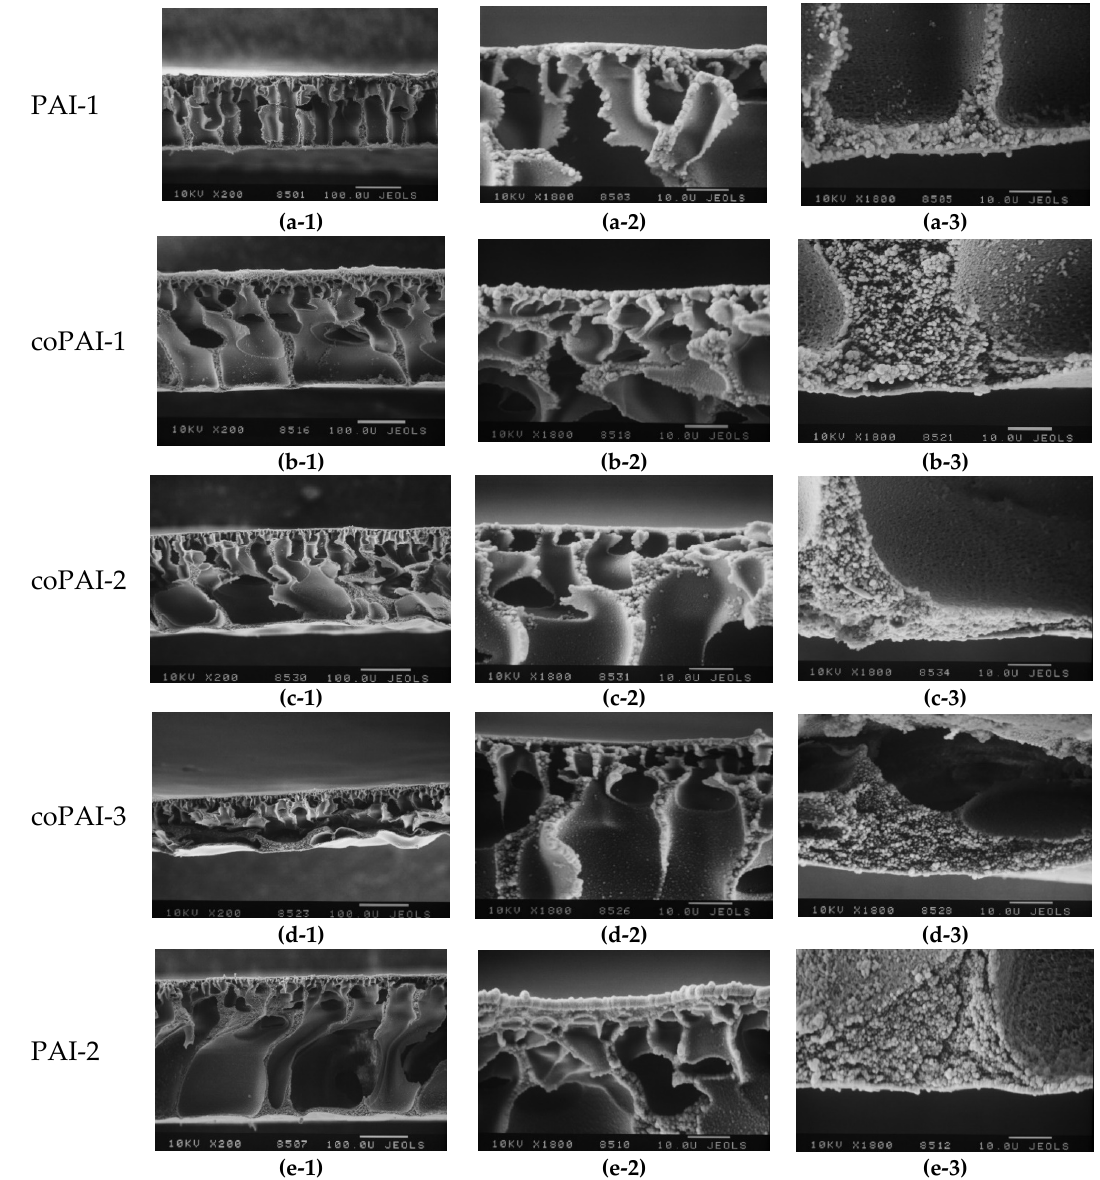
Figure 8. SEM images of low-temperature fractures of asymmetric membranes PAI-1(0% DABA; a-1 , a-2 , a-3 ), coPAI-1(30% DABA; b-1 , b-2 , b-3 ), coPAI-2 (50% DABA; c-1 , c-2 , c-3 ), coPAI-3 (70% DABA; d-1 , d-2 , d-3 ), and PAI-2 (100% DABA; e-1 , e- 2 , e-3 ). ( a-1 , b-1 , c-1 , d-1 , e-1 )—general cross-sectional view; ( a-2 , b-2 , c-2 , d-2 , e-2 )—top cross-sectional view; (a -3,b-3,c-3,d-3,e- 3 )—bottom cross-sectional